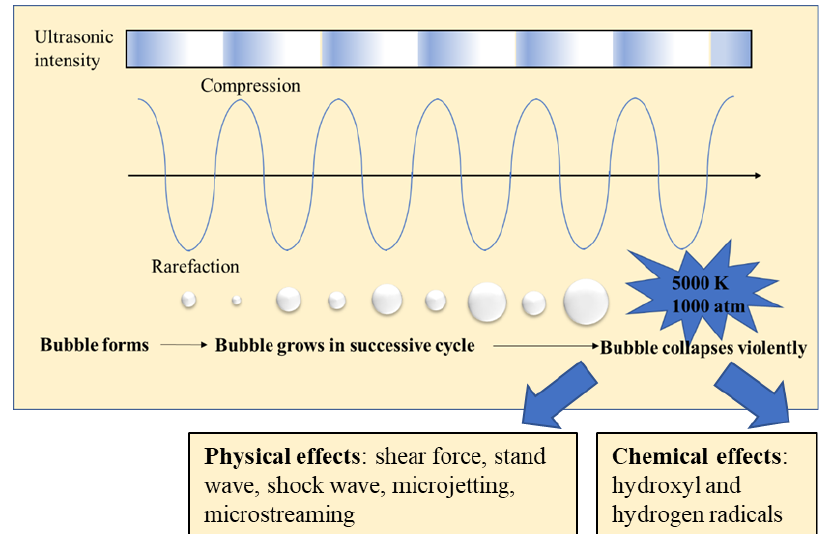
Figure 1. A schematic representation of the acoustic cavitation